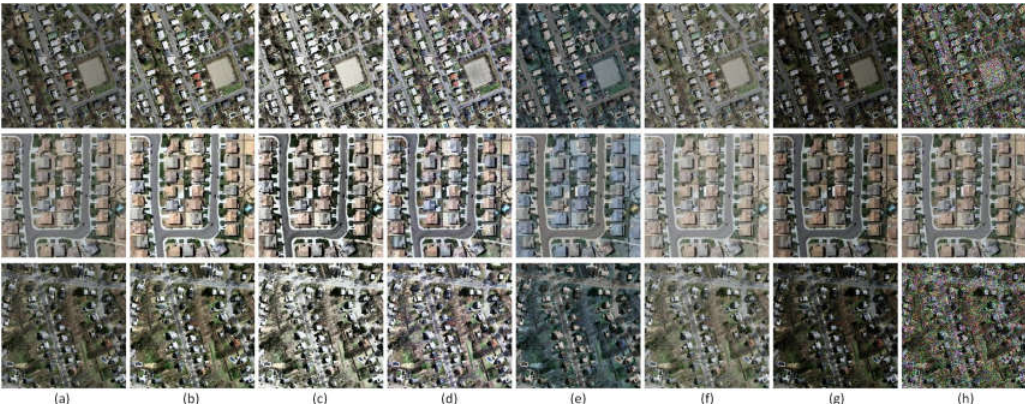
Figure 6. Image transformation methods of data augmentation: ( a ) Original image. ( b ) Image after contrast stretching. ( c ) Image after histogram equalization. ( d ) Image after adaptive histogram equalization. ( e ) Image after color space change. ( f ) Image after gamma correction (gamma = 0.7). ( g ) Image after gamma correction (gamma = 1.5). ( h ) Image after added random noise.